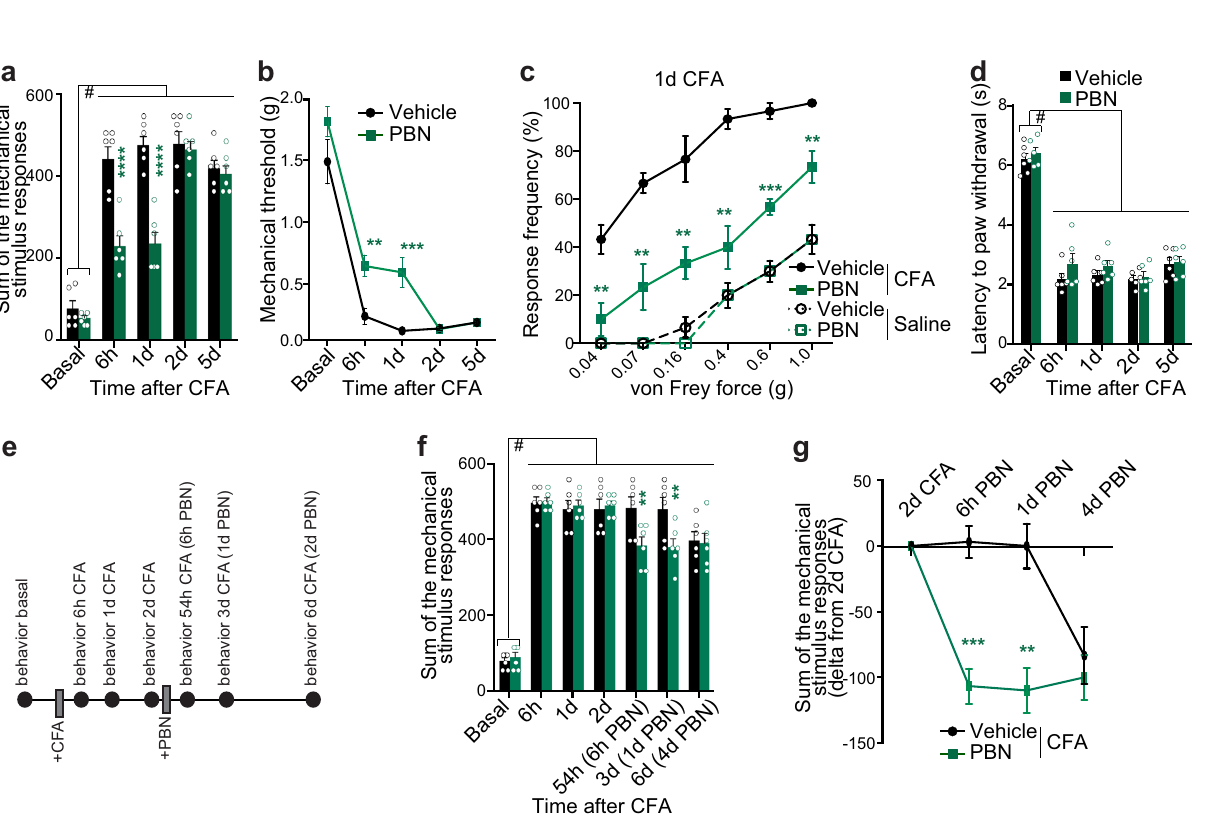
Fig. 6 Inhibition of OAT1 reduces in fl ammatory hypersensitivity. a Mechanical sensitivity following intraplantar CFA injection, represented as the sum of stimulus-evoked responses to von Frey fi laments. b 40% response threshold to mechanical force via von Frey fi laments. c Stimulus intensity-response frequency curve for plantar von Frey mechanical stimulation for the same cohort of mice shown in ( a , b ) 24 h after intraplantar CFA injection. d Paw withdrawal latency to a radiant heat light source for all fi laments ( a – d , n = 6). e Timeframe of the experiment. f Sum of the stimulus-evoked responses to von Frey fi laments at the indicated timepoints for mice that received intrathecal injection of probenecid (PBN) or vehicle two days after CFA delivery. g Sum of mechanical stimulus-evoked responses at the indicated timepoints for the same cohort of mice as in ( f ), calculated as the difference relative to values obtained on the day of intrathecal injection of PBN or vehicle. ( f , g , n = 6). Statistically signi fi cant differences were determined by two- way ANOVA with repeated measures followed by Dunnett ’ s post hoc test for comparisons to basal values and multiple t -test with Holm-Sidak correction ( a , F (4,40) = 229.2 F (1,10) = 14.48; b , F (4,40) = 137.6 F (1,10) = 9.686; c , F (5,100) = 73.10 F (3,20) = 82.41; d , F (4,40) = 182.1 F (1,10) = 2.408; f , F (6,60) = 247.5F (1,10) = 1.062; g , F (3,30) = 20.21 F (1,10) = 17.16). **** p < 0.0001; *** p < 0.001; ** p < 0.01; # p < 0.0001. Asterisks (*) refer to statistical comparisons between conditions and hashtags ( # ) to comparisons relative to basal values in each condition. Graphs represent mean ± of CFA-triggered mechanical hypersensitivity but does not affect basal sensitivity.